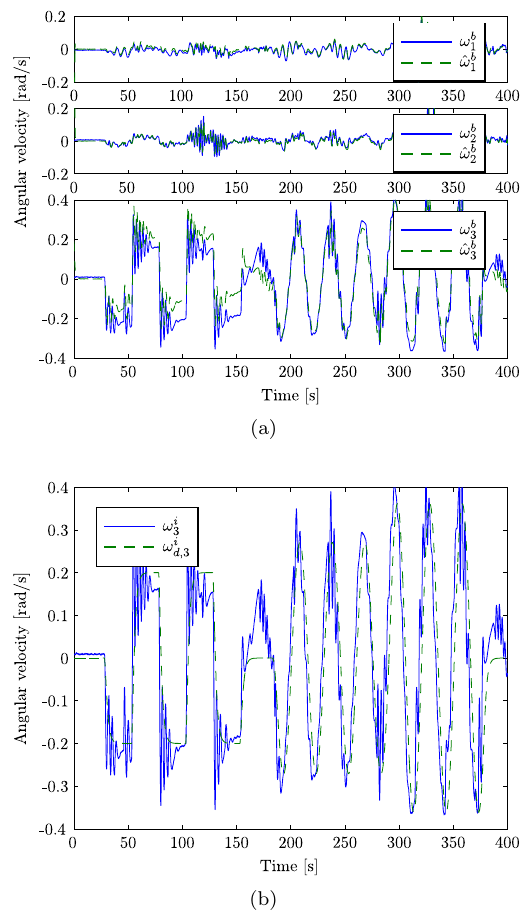
Figure 5: Experiments with observer. (a) shows mea- sured and estimated velocity about x , y and z axis. (b) compares the reference against the filtered angular velocity about the z